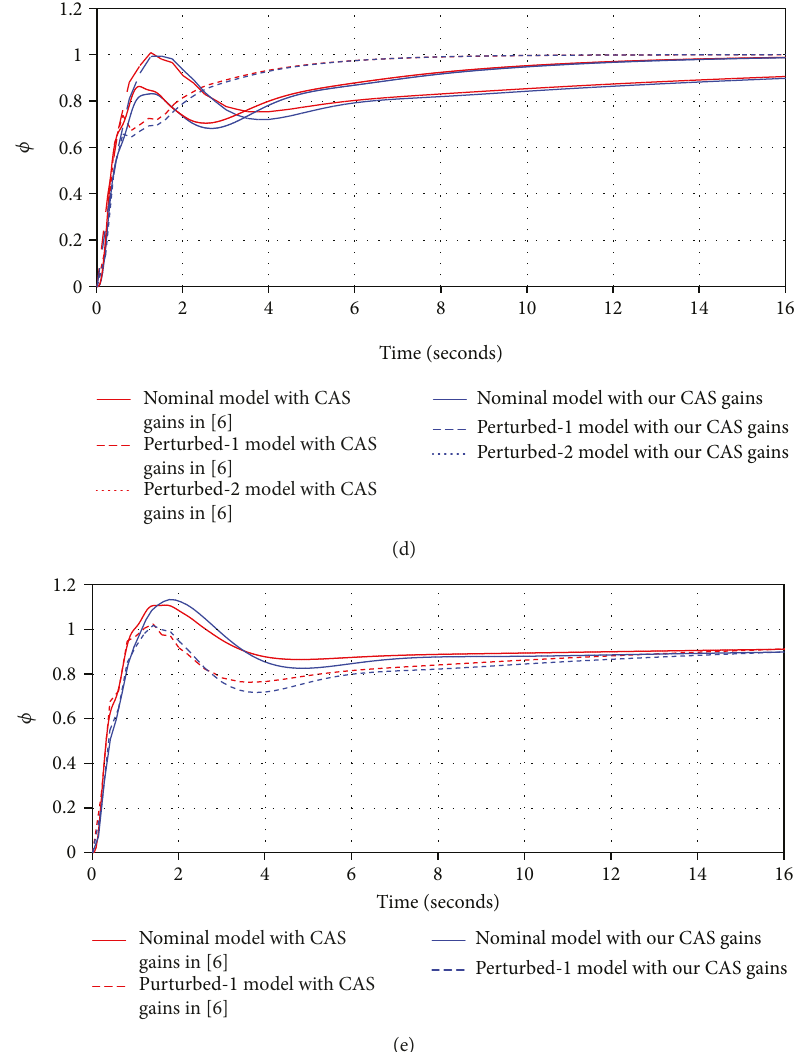
Figure 9: Step responses of using oscillation suppression CAS gains in Table 2 and CAS gains in [6] at (a) clean, (b) T00, (c) T15, (d) T70, and (e) T90.